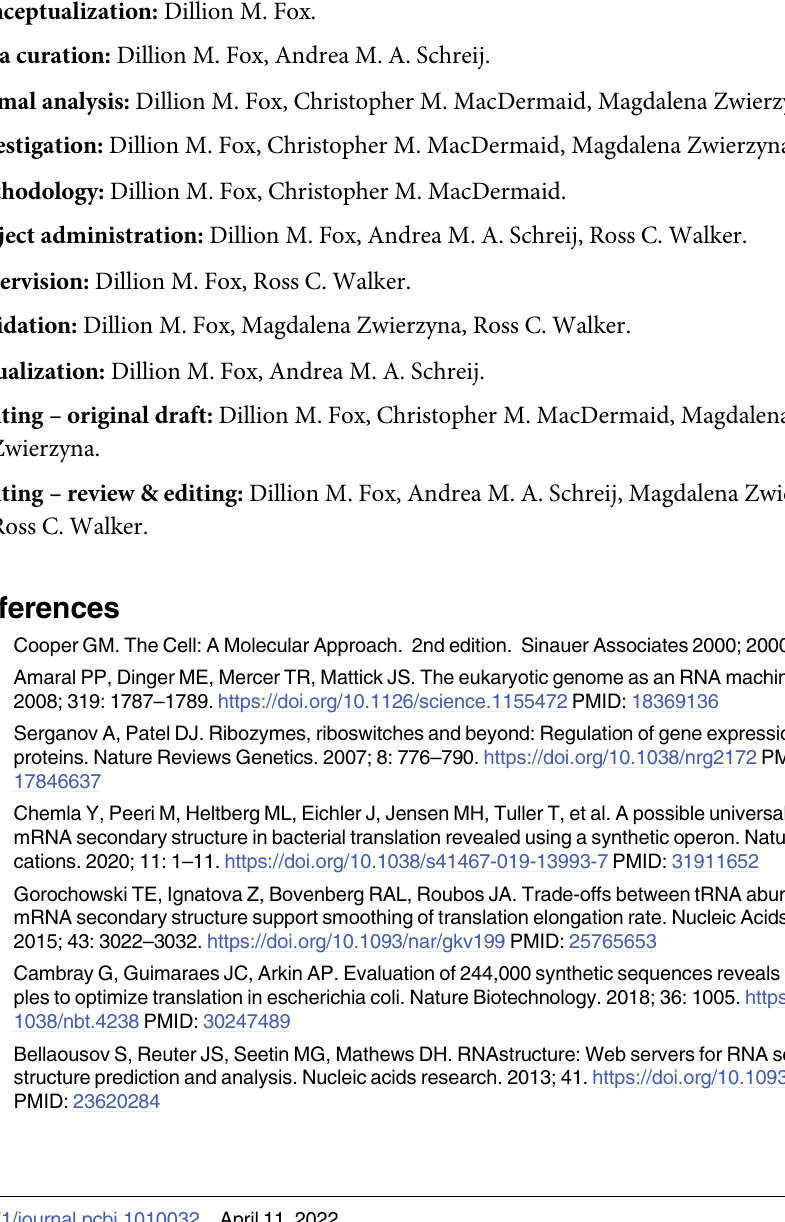
sequence in the large test set (sequences containing more than 45 stems) using REMC and QC methods. Each method was run ten times. Names derive from PseudoBase. Bolded numbers at the bottom of each column represent the mean. Table C. Sensitivity and specificity scores for each sequence in the large test set (sequences containing more than 45 stems) using three methods found in literature. Bolded numbers at the bottom of each column represent the mean. Table D in S1 Text. Direct programming QPU vs Hybrid